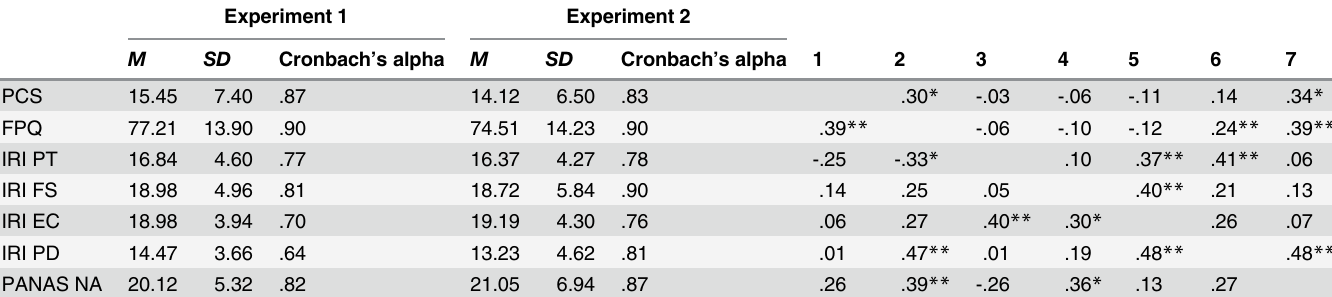
Table 1. Means (M), Standard Deviations (SD), Cronbach ’ s Alpha, and Pearson Intercorrelations of the Questionnaires. Experiment